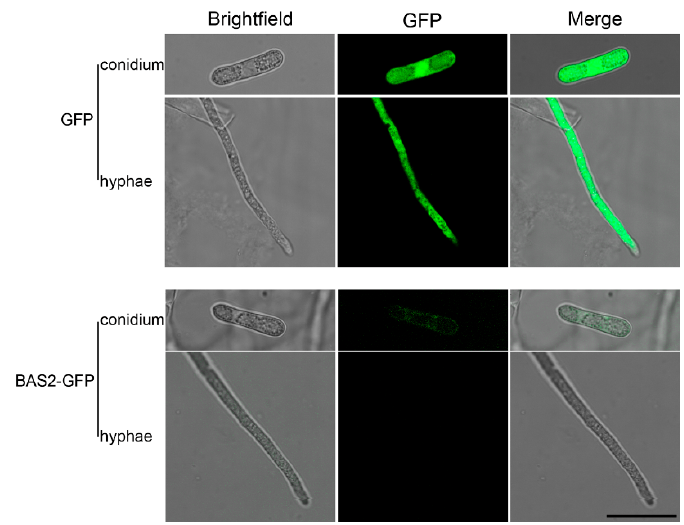
Figure 3. Subcellular localization of BAS2-green fluorescent protein (GFP) in conidia and hyphae of C. gloeosporioides . Scale bar = 20 μ m.